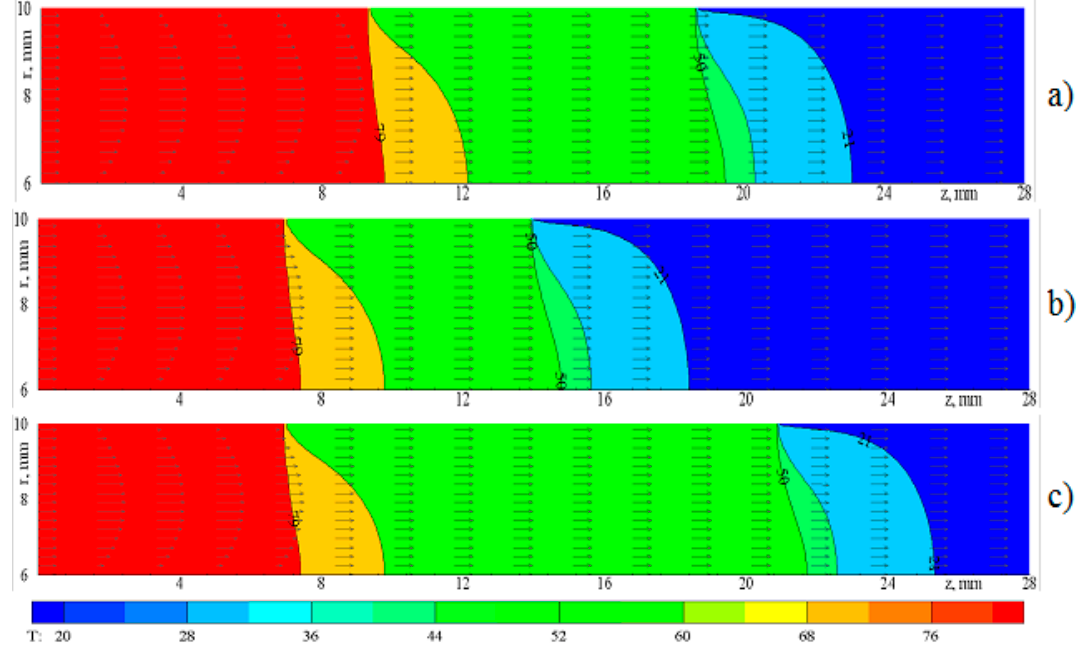
Figure 2. Distributions of the temperature over the annular cavity length at different ratio of the length of the cooling circuits at 𝑢 (cid:2868) = 20 𝑚𝑚/𝑚𝑖𝑛 , ( а ) L 1 = L 3 = 9.4 mm, L 2 = 9.2 mm; ( b ) L 1 = L 2 = 7 mm, L 3 = 14 mm; ( c ) L 1 = L 3 = 7 mm, L 2 =